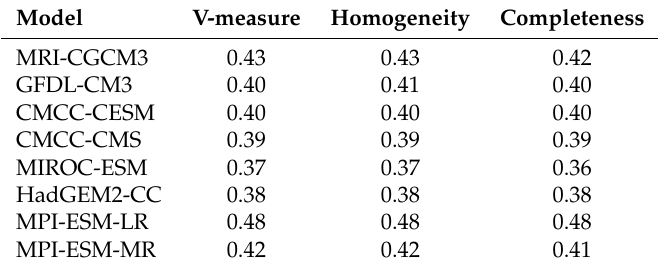
Table 3. V-measures [41] derived from two different mappings of RCP8.5 data mapped on RCP8.5 SOMs and on historical SOMs. A V-measure equal to 1 would mean that both approaches group the RCP8.5